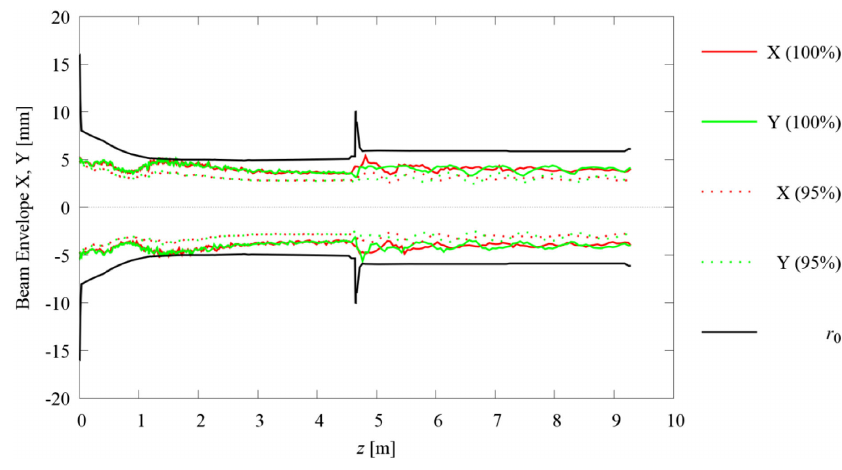
FIG. 4. Transverse beam envelopes for all particles as well as for 95% of the